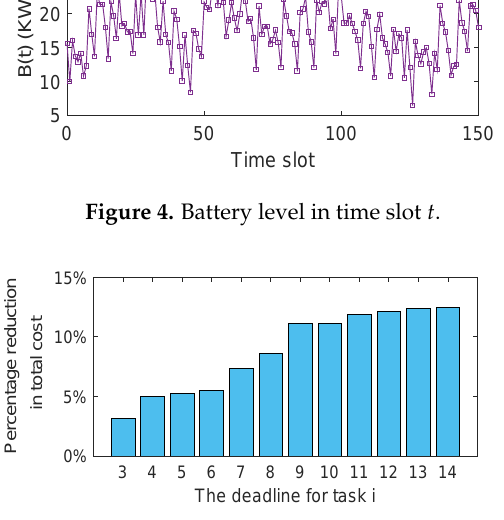
Figure 5. The percentage of the reduced cost.